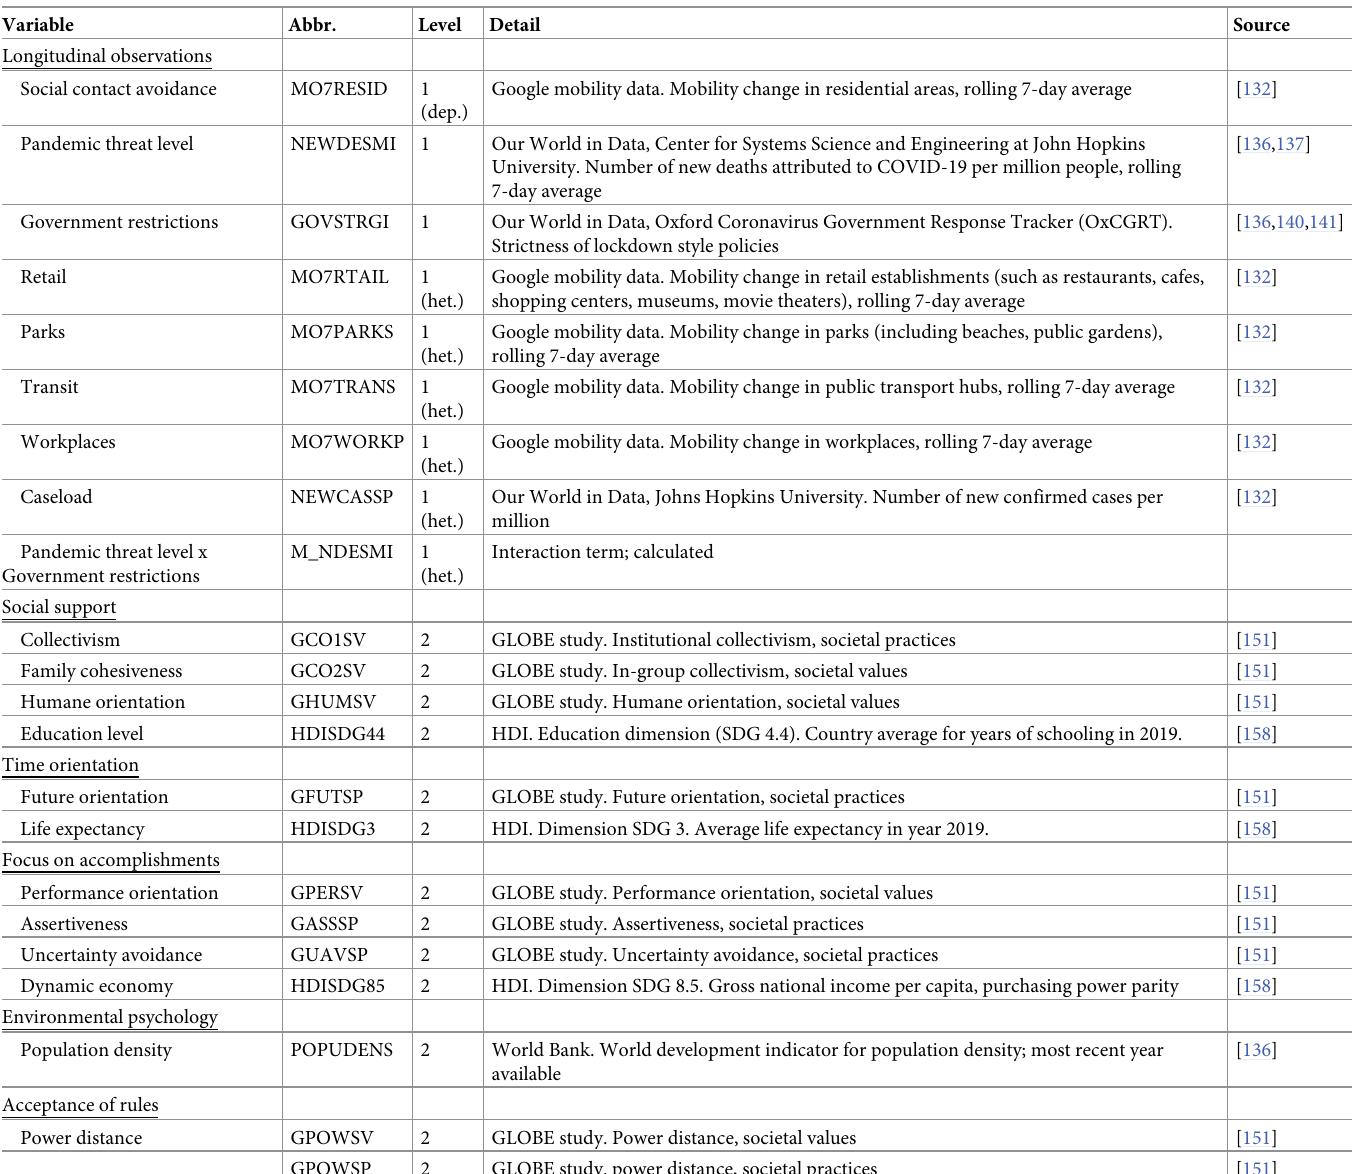
Table 1. Variables in the research